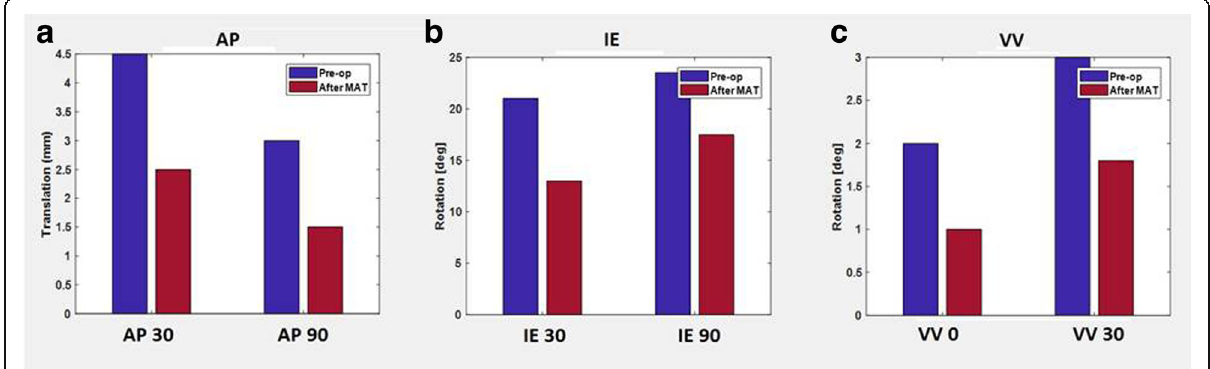
Fig. 8 Laxity evaluation: AP30 and AP90 ( a ), IE30 and IE90 ( b ), VV0 and VV30 ( c ) for Lateral